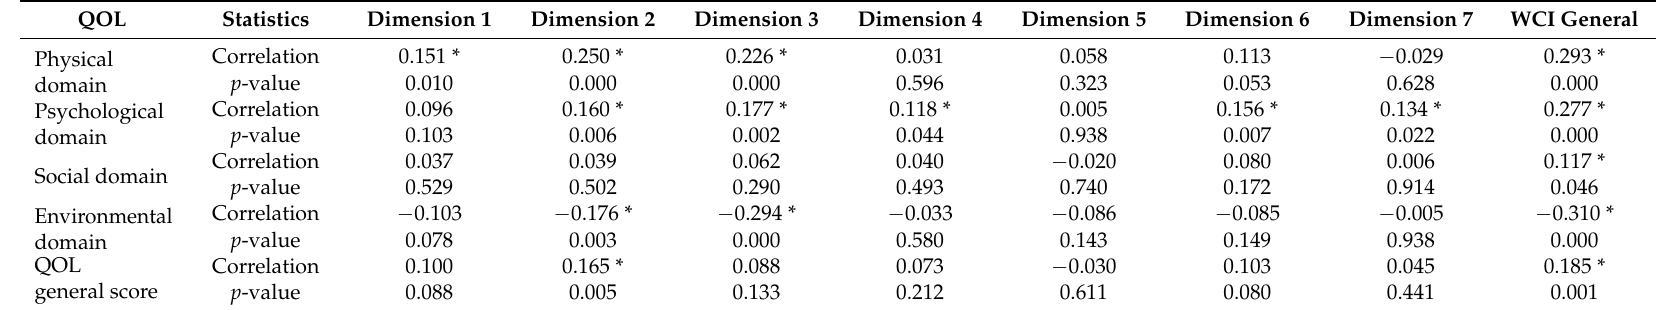
Table 6. Correlations between QOL and the WCI using Spearman’s correlation